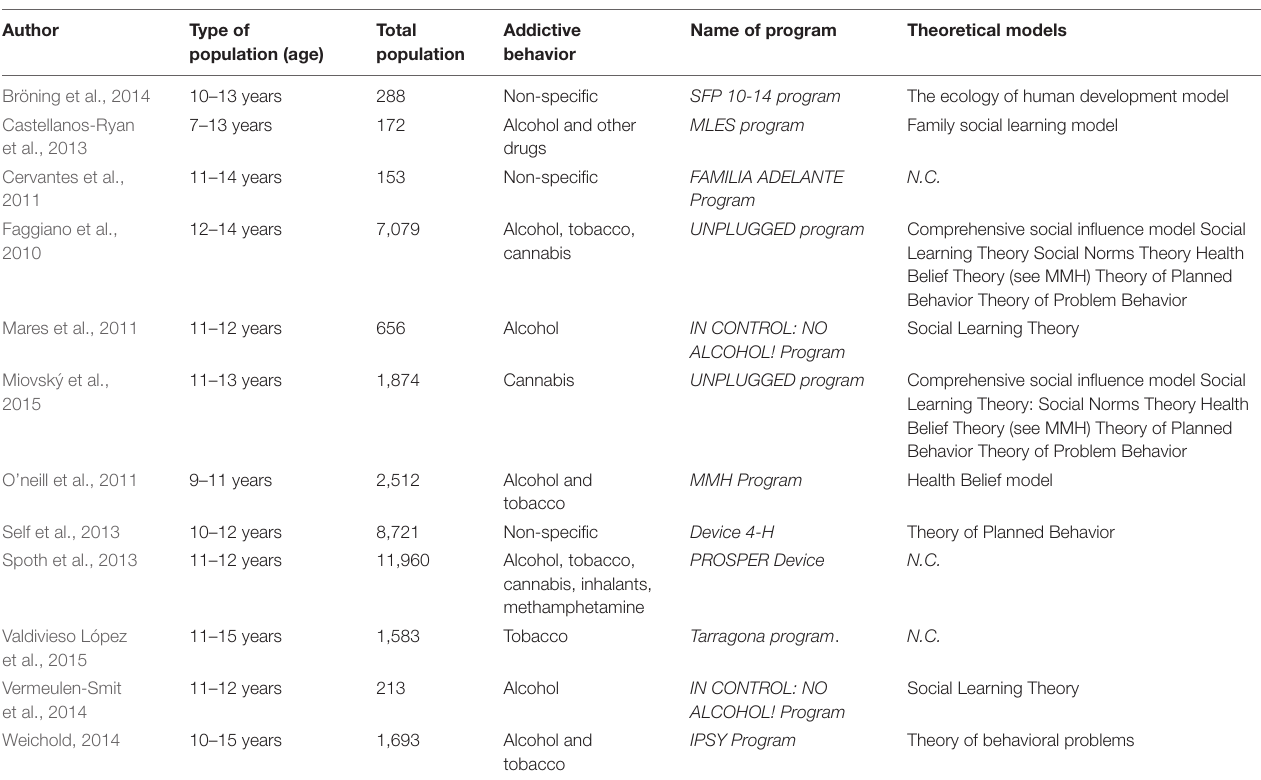
TABLE 2 | Synthesis of prevention programs included in the literature review and their theoretical